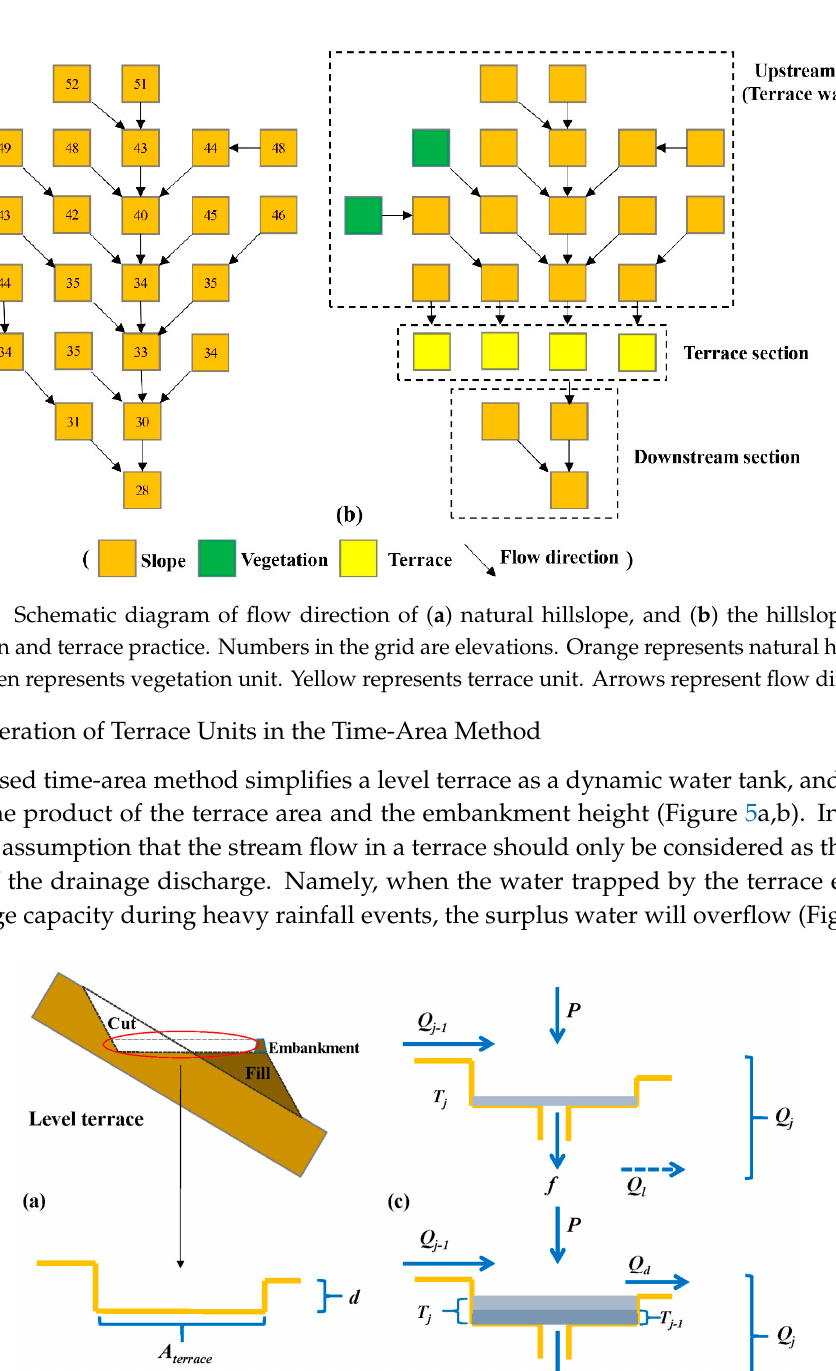
Figure 5. Schematic diagrams of the hydrological processes and flow distribution of the level terrace unit. ( a ) Section profile of a level terrace. ( b ) The generalization of the level terrace in ( a ). The flow distribution assumes that the soil profile of the terrace is deep enough for subsurface flow